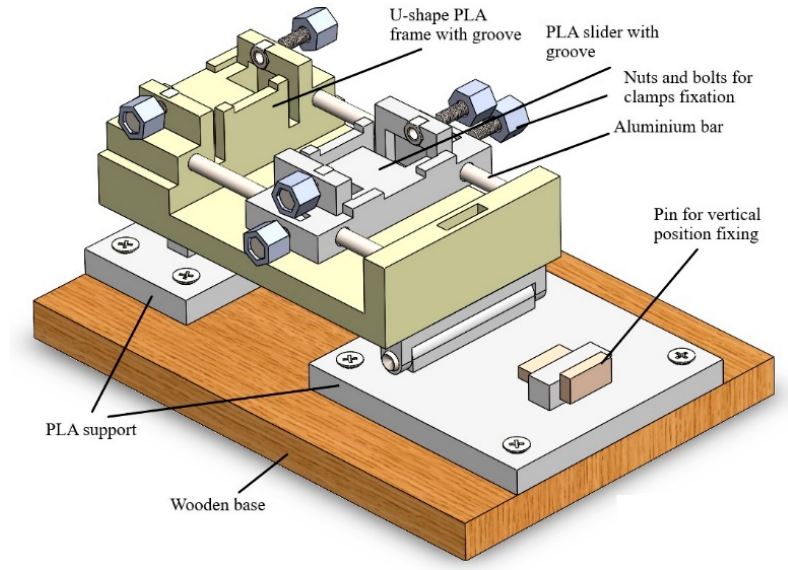
Figure 4. The horizontal position of the calibration device.